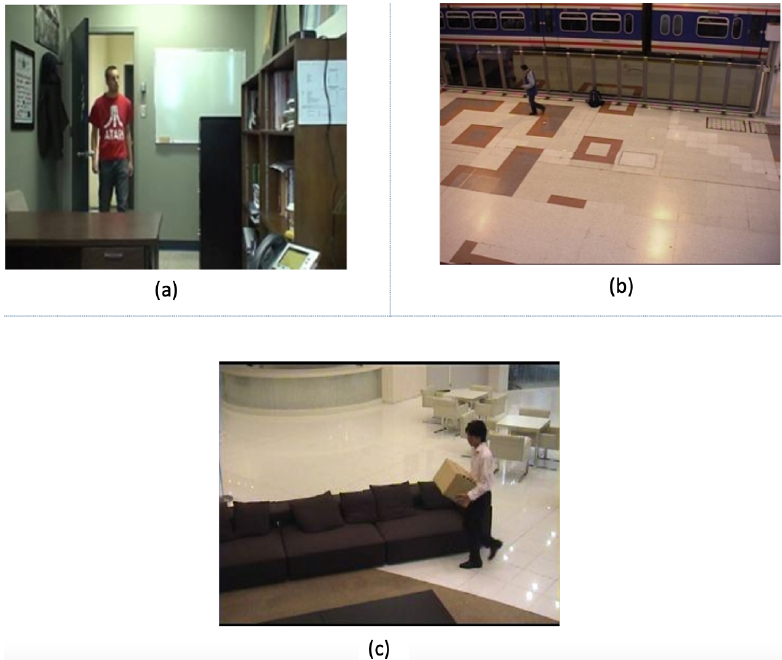
Figure 1. Scenes selected from the CDnet2014 database: ( a ) office, ( b ) PETS2006, and ( c ) sofa.